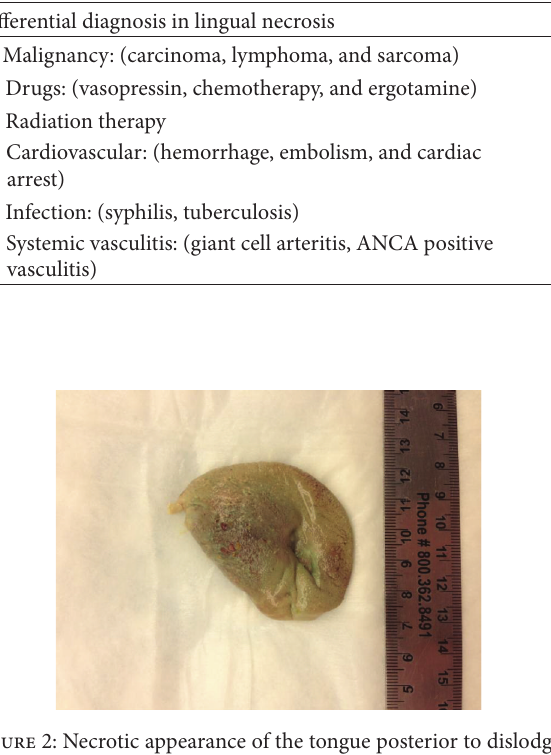
Table 2: Differential diagnosis in lingual necrosis.